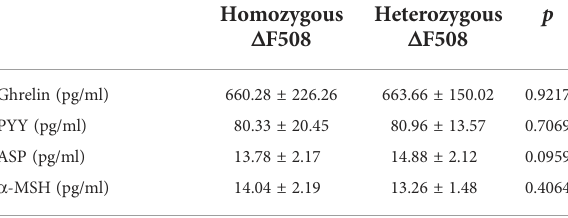
TABLE 3 Hormone levels by CFTR mutation of CF